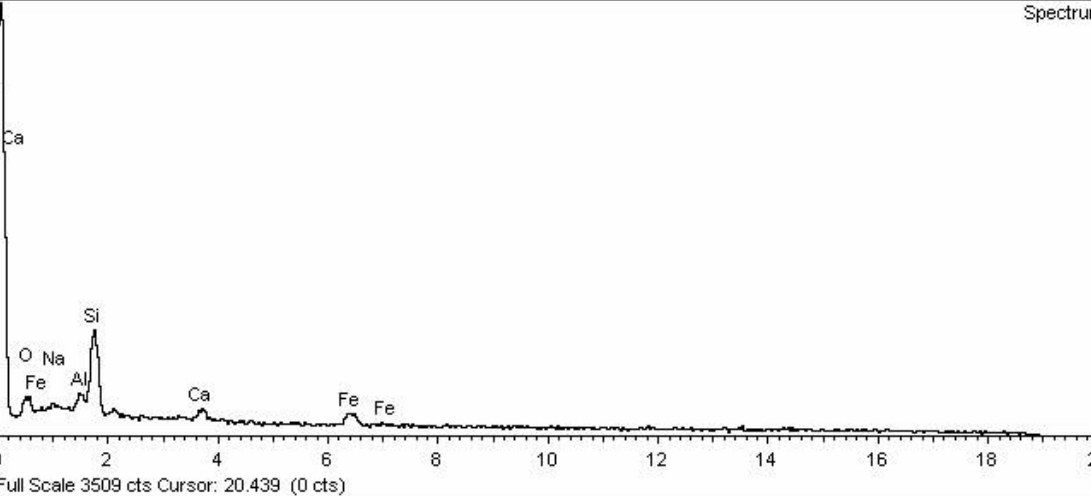
Figure 10. EDX analysis of concrete powder with 2% soap solution and RHA.